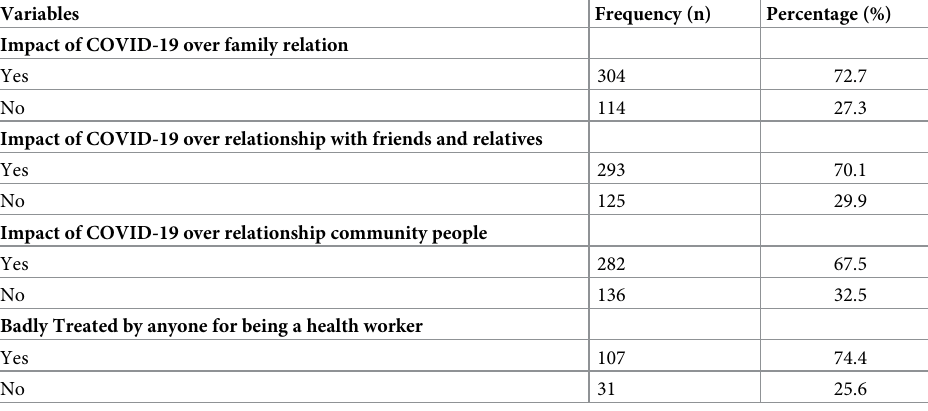
Table 3. Social impact of COVID-19 experienced by health professionals (n = 418).